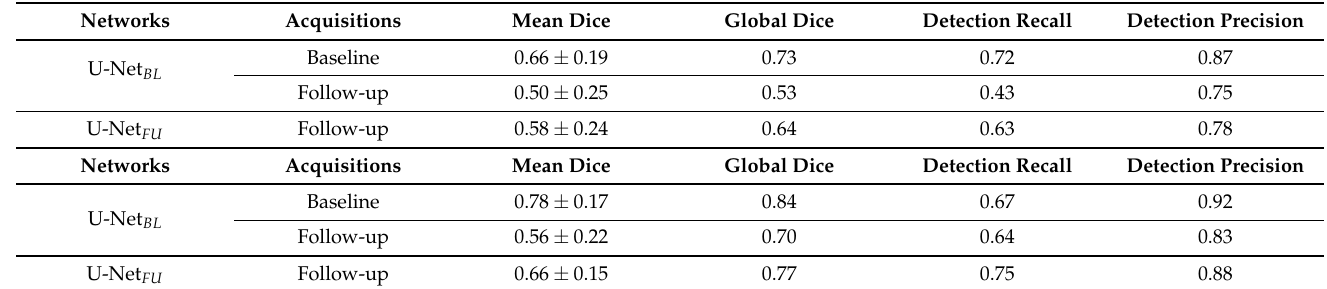
Table 1. Quantitative evaluation for the two networks on baseline and follow-up acquisitions. (a) Evaluation on validation data. For each network, validation performances were computed for its 5 models from the cross-validation training and then averaged. (b) Evaluation on test data. For each network, models from the cross-validation training were combined in one single ensemble model and test performances were computed with this model. Only 10 unseen patients with one baseline and one follow-up acquisition were used.